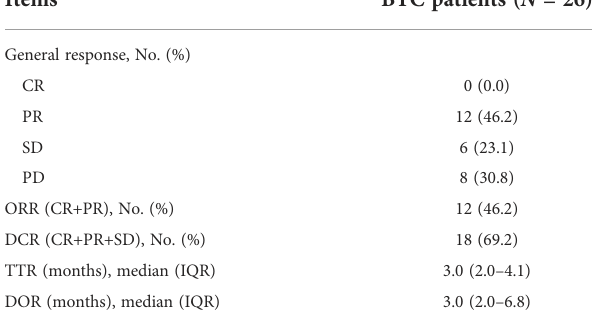
TABLE 2 Best treatment response.